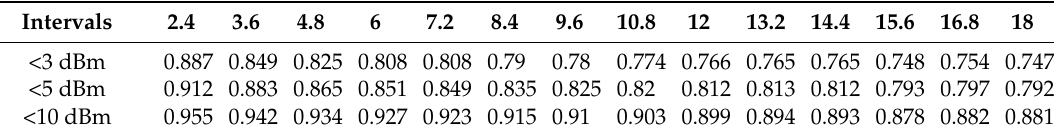
Table 5. The statistics probabilities of absolute RSS differences ranges between manual radio map and the adaptive path loss model interpolated ones.